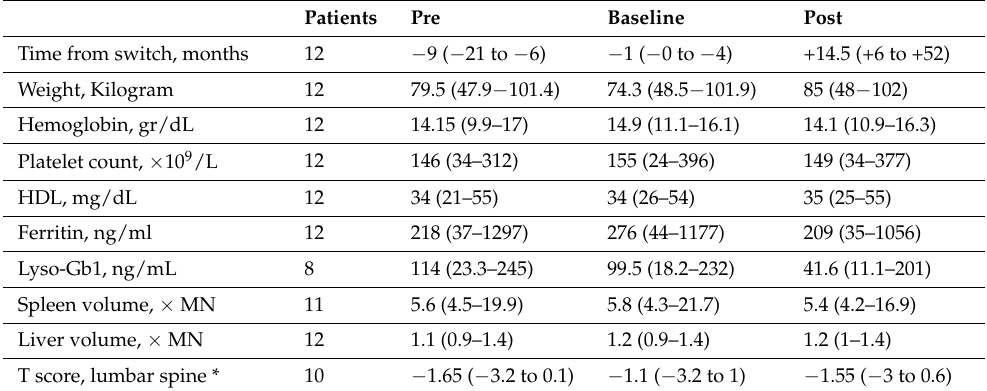
Table 3. Changes in clinical and laboratory parameters between the three-time points- Pre, at least 6 months before the switch; Baseline; less than 6 months before the switch; Post, at least 6 months after the switch.